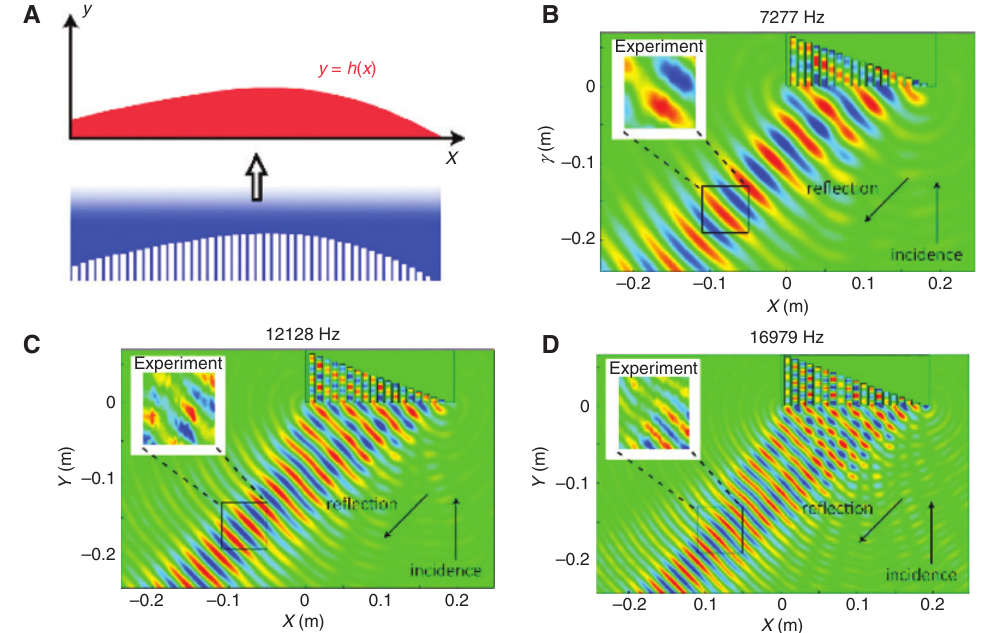
Figure 4: Reflective metasurfaces with nearly dispersion-free functionality. (A) Schematic of metasurface made of grooves with subwavelength width below the surface. Blue region is filled with acoustically rigid medium, and the depth of grooves is a function of x . (B–D) Simulated and measured spatial distribution of extraordinary reflection at three particular frequencies (reprinted from Ref.